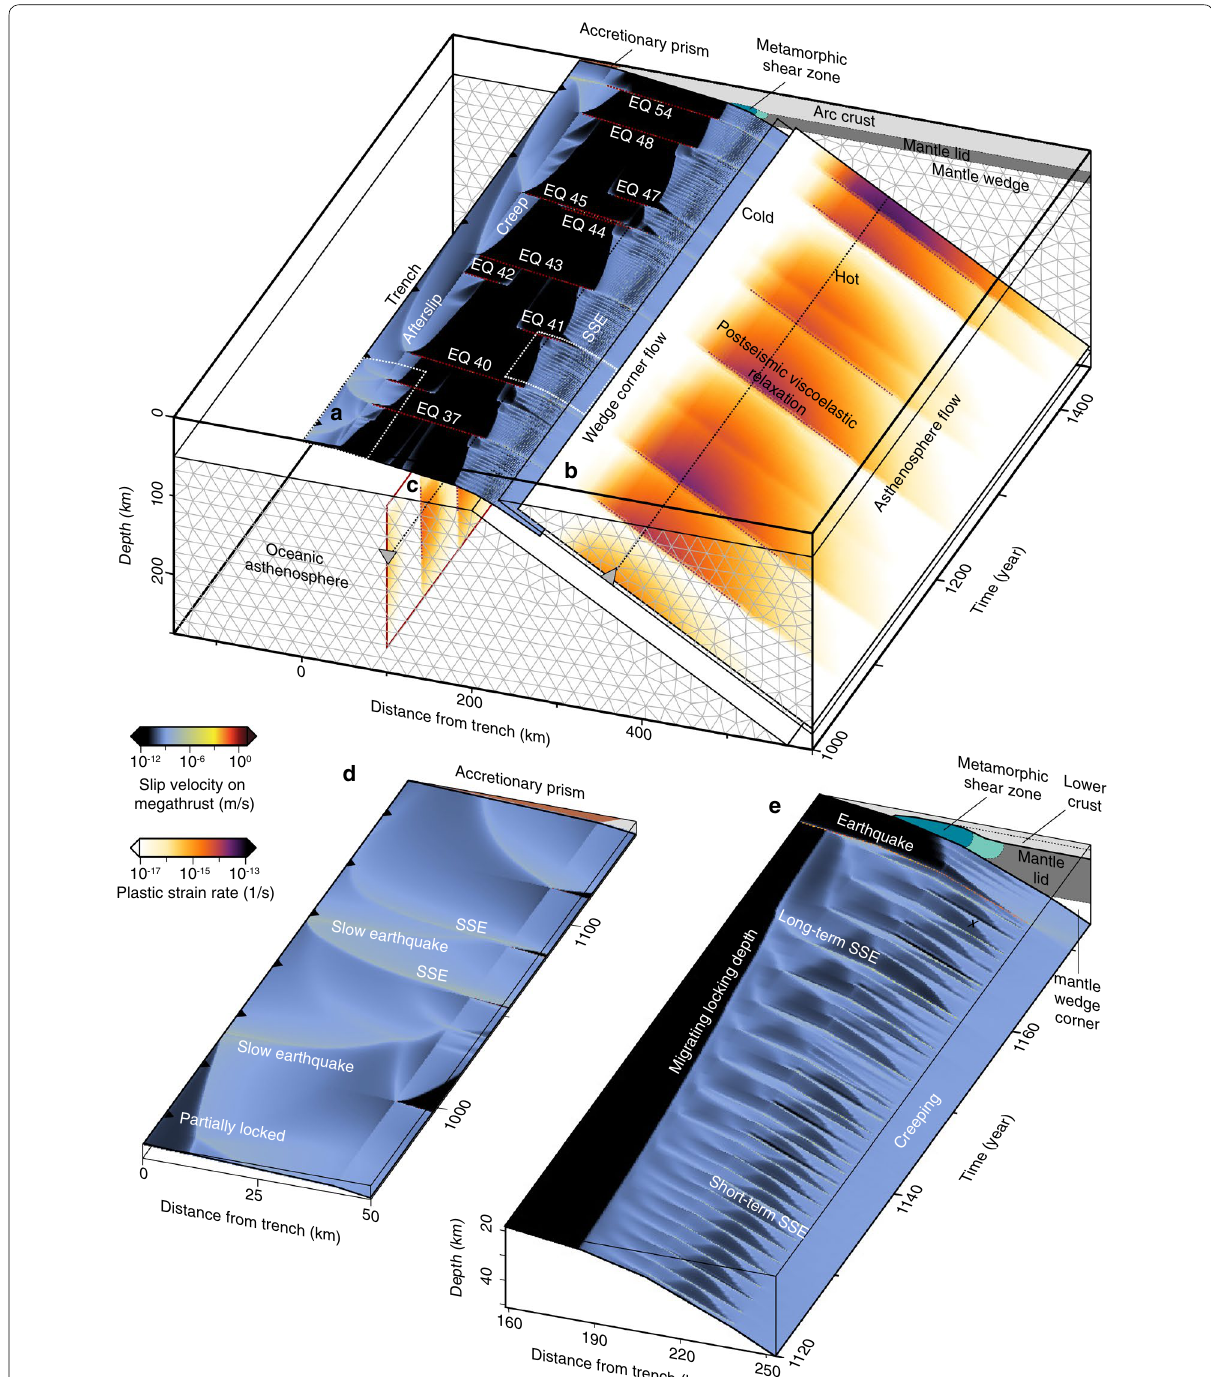
Fig. 3 Space-time evolution of brittle and ductile dynamics in a model subduction zone. a The fault dynamics showcases full and partial ruptures, long-term and short-term slow-slip events, and afterslip. The shallow section is characterized by non-stationary dynamics, with afterslip, creep waves, and long-term variations of partial locking. b , c The viscoelastic flow is modulated by the stress change impacted by large ruptures. The periods of viscoelastic relaxation are followed by periods of strain-deficit accumulation late in the interseismic period. d Dynamics of the shallow segment underneath the accretionary prism. e Dynamics of interacting long-term and short-term slow-slip events with fast ruptures in the seismogenic